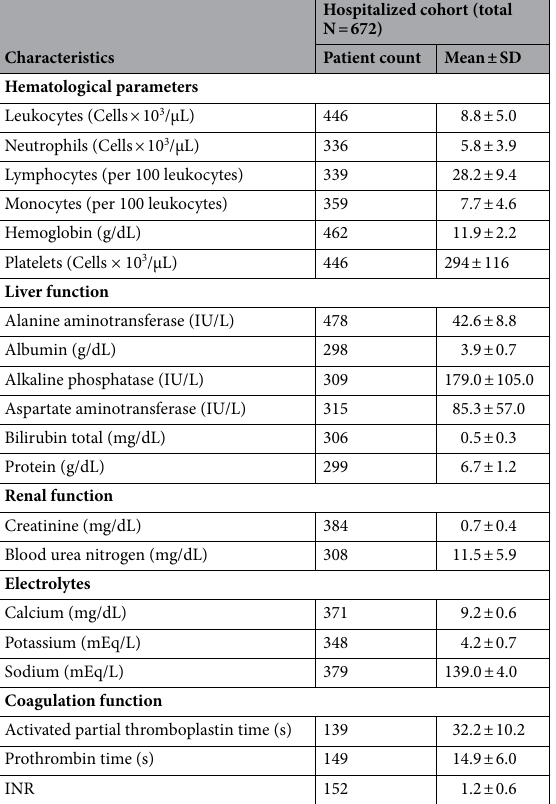
Table 2. Laboratory measures of the hospitalized patients. SD standard deviation.